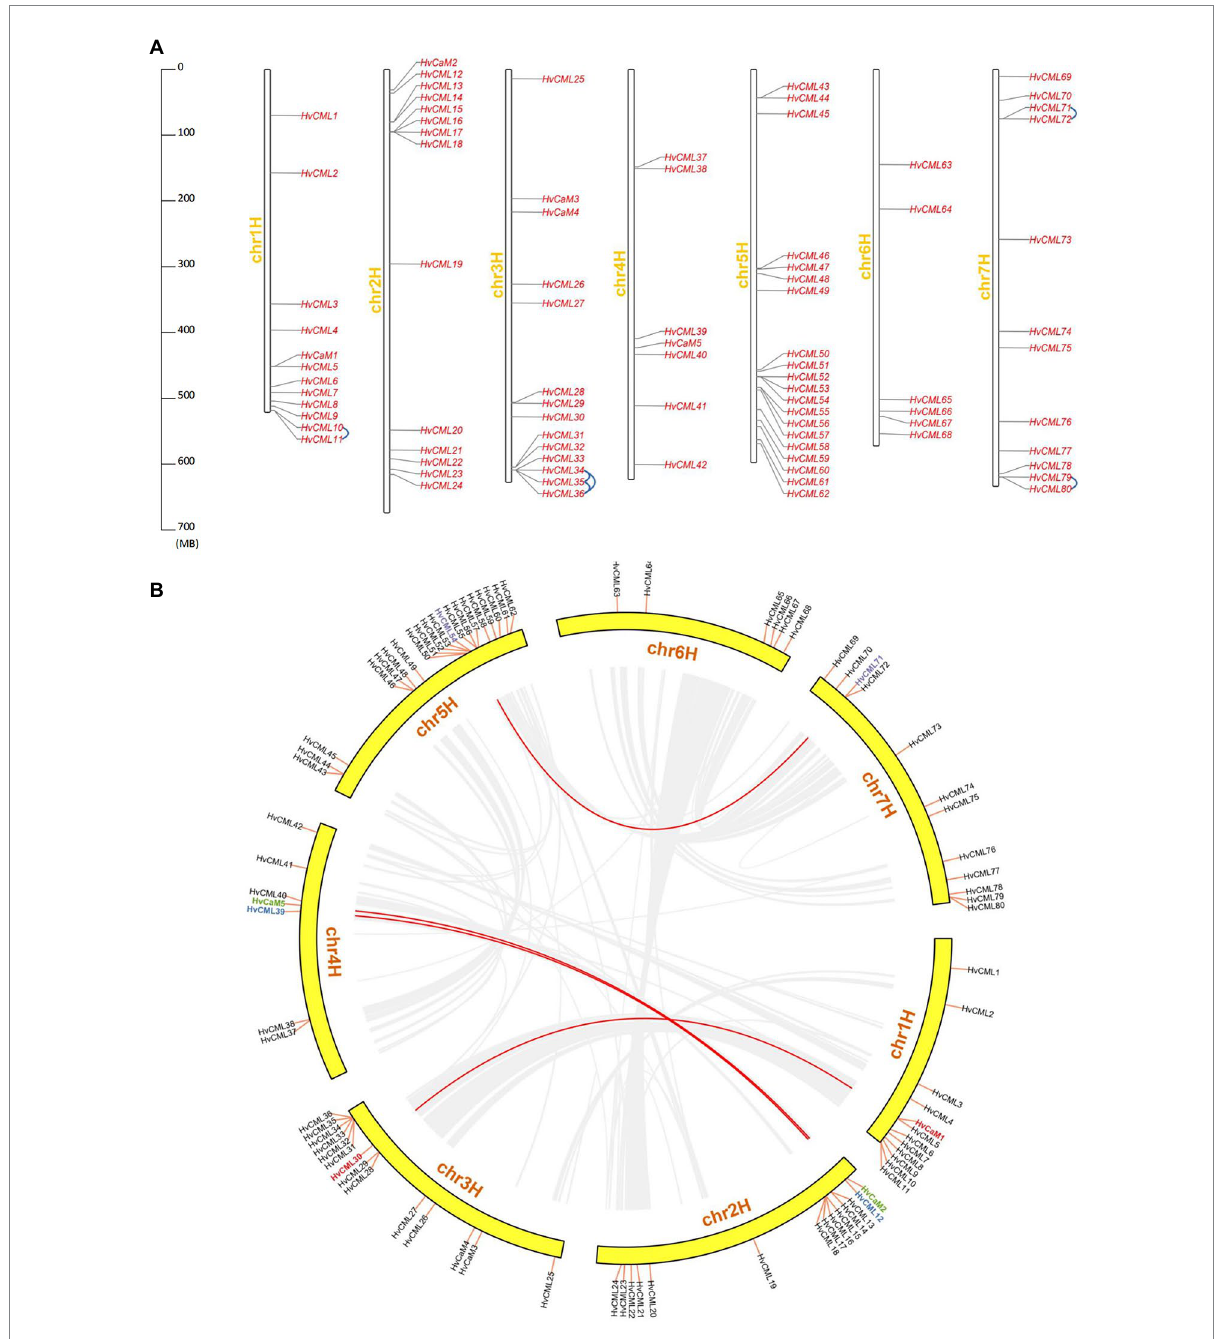
FIGURE 3 Chromosomal distribution and duplication of HvCaMs/CMLs . (A) Chromosomal distribution and tandem duplication of HvCaMs/CMLs ; (B) Segmental duplication of HvCaMs/CMLs